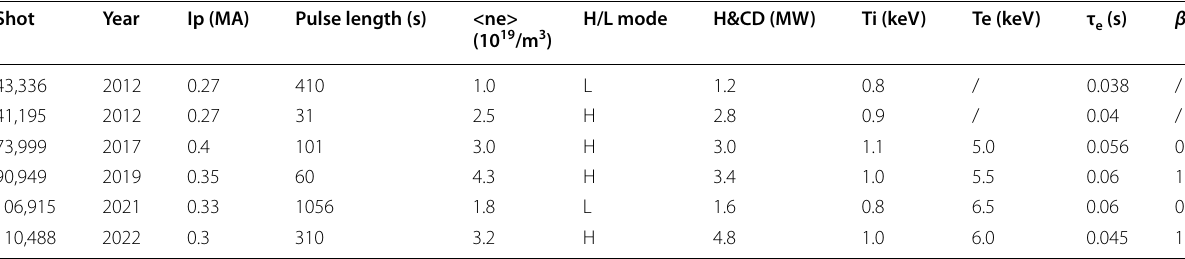
Table 3 Parameters in typical long pulse plasmas in EAST